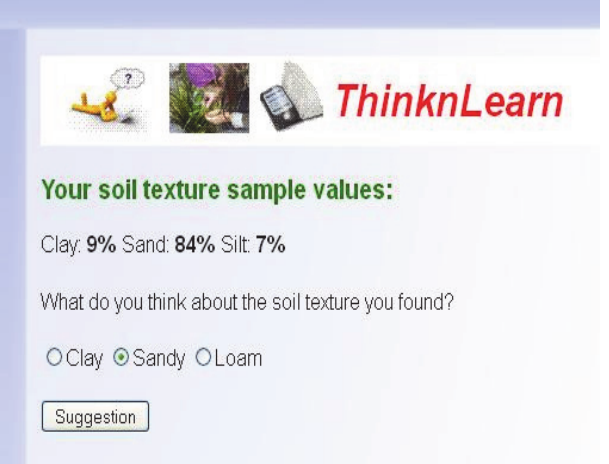
Figure 6 . MCQ about soil texture type.